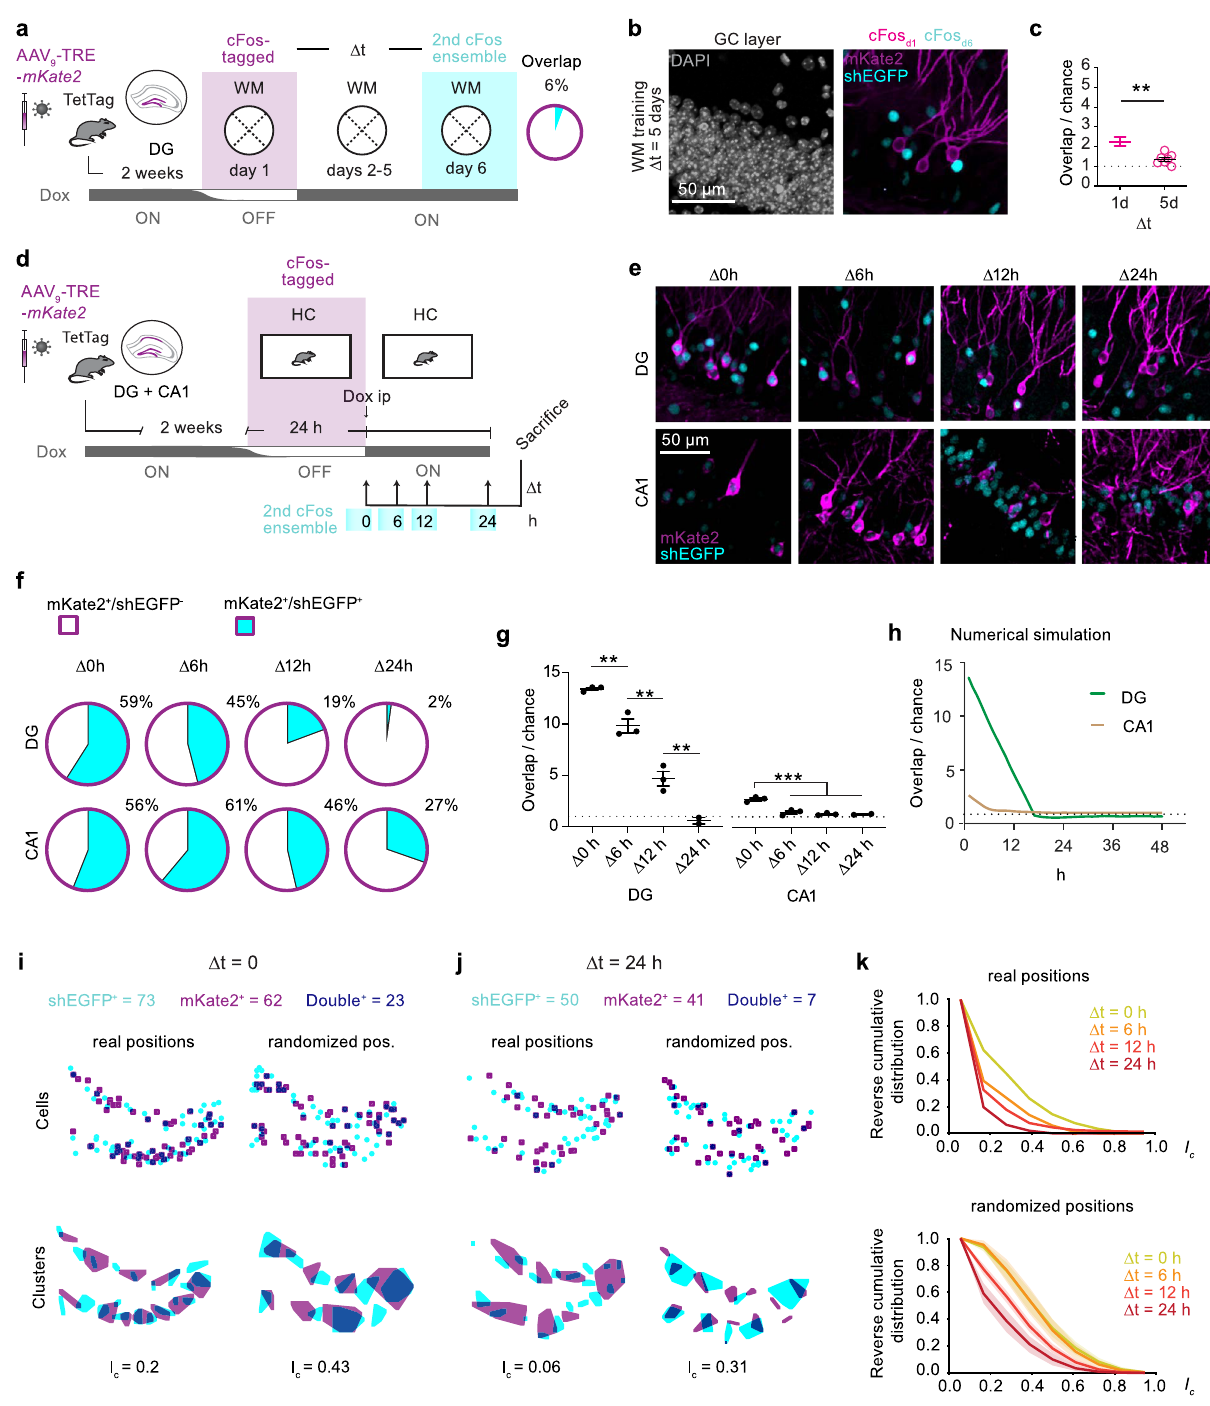
Fig. 5 | Temporal dynamics of cFos overlap in dentate gyrus. a Experimental timeline and cFos overlap. TetTag mice were injected with AAV 9 -TRE- mKate2 in dentate gyrus (DG) to tag cFos + neurons on training day 1 (magenta shading, cFos d1 ). They were trained for 6 days and sacri fi ced for shEGFP immunostaining (cyan shad- ing,cFos d6 ). b Immuno fl uorescenceexampleimagesfromthegranulecell(GC)layer showing low overlap between cFos d1 (magenta) and cFos d6 (cyan). c After 5 days of WM training, cFos overlap was not signi fi cantly different from chance ( n =7 mice, two-way-ANOVA, p =0.11, see Supplementary Figure 2) and signi fi cantly lower (** p =0.003, two-sided, unpaired t test) than after 1 day of WM training (RT group, datafromFig.2d). d Homecageexperiment.TetTagmicewereinjectedAAVinjected withAAV 9 -TRE- mKate2 inDGandCA1regions.DoxwasremovedtotagcFosneurons whilemicewereintheirhomecage(HC).Miceweresacri fi cedatdifferenttimepoints afterDoxinjection. e IFstainingofcFos-taggedandshEGFP(cFos + )neuronsinDGand